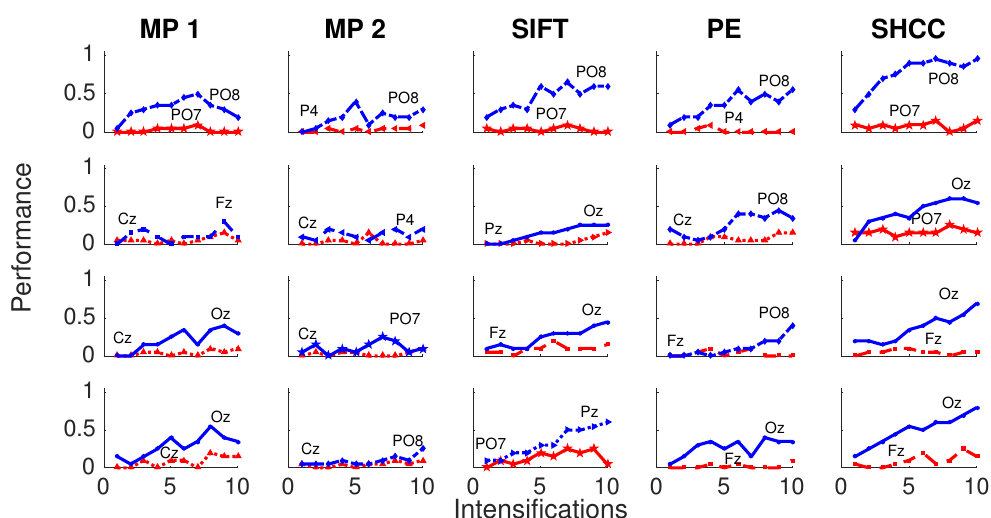
Figure 11. Active Modality—Experiment 3:Performance curves for four subjects for the five algorithms when the amplitude of the P3b component of the template is randomly attenuated.